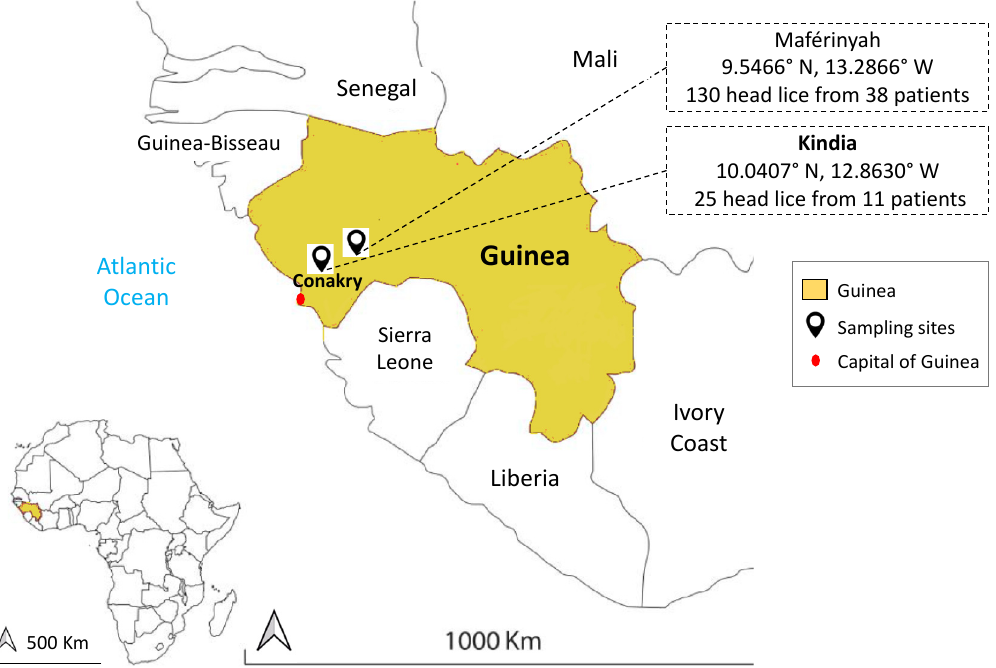
Figure 1. Map of head lice collection sites from infested individuals in two localities in Guinea.